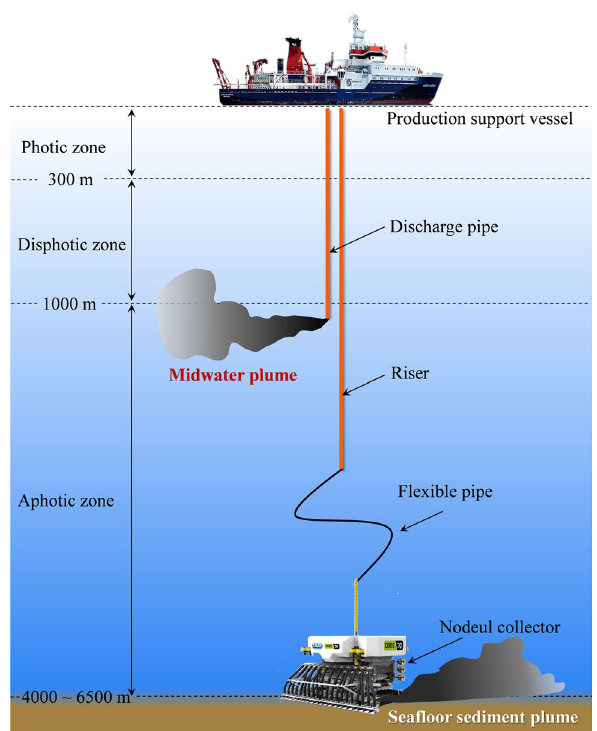
Fig. 23 Schematic diagram of a deep seabed mining system and plume (modified from Muñoz-Royo et al. 2021; photos taken by JAGO team/GEOMAR and QC2000 Nodule Collector developed by